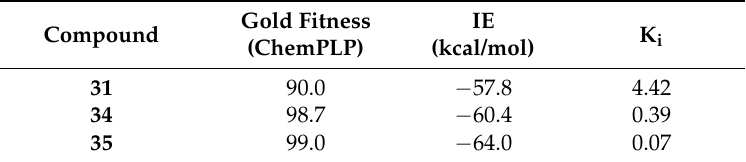
Table 3. Results of the docking studies with gold fitness values (PLP: Piecewise Linear Potential) and interaction energies